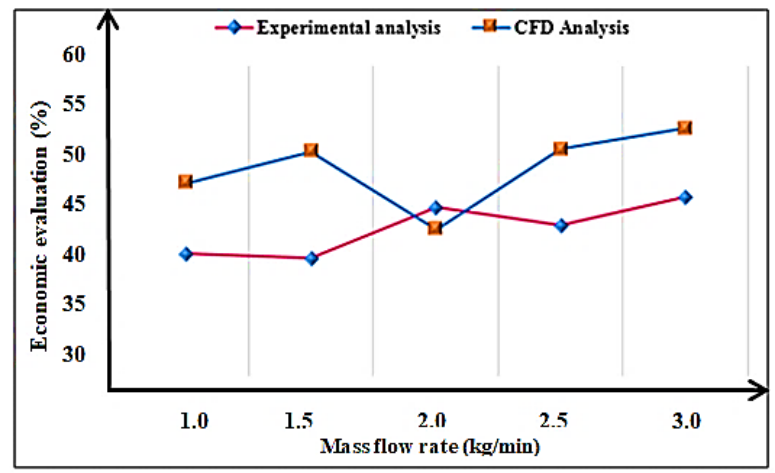
Figure 11 . Economic evaluation. Figure 11. Economic evaluation.